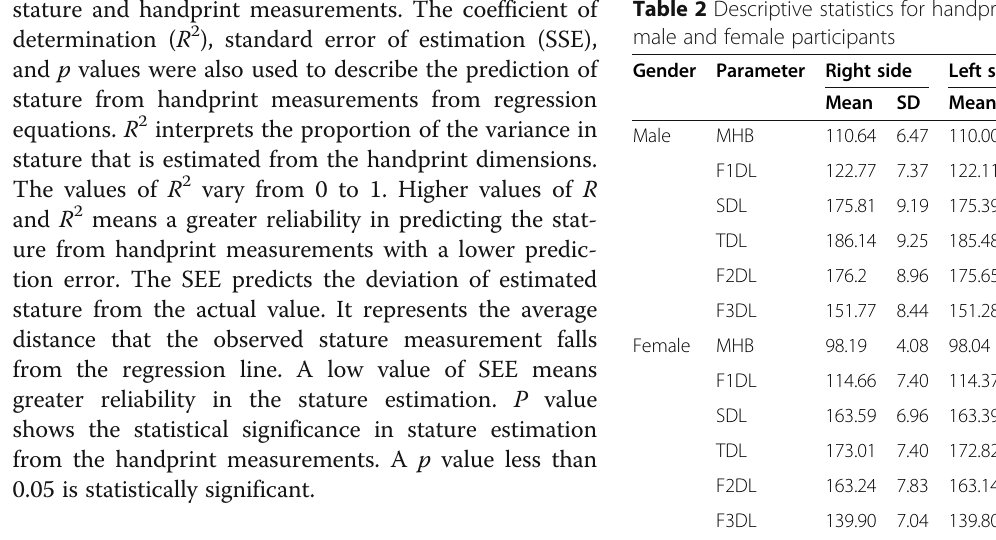
Table 2 Descriptive statistics for handprint measurements